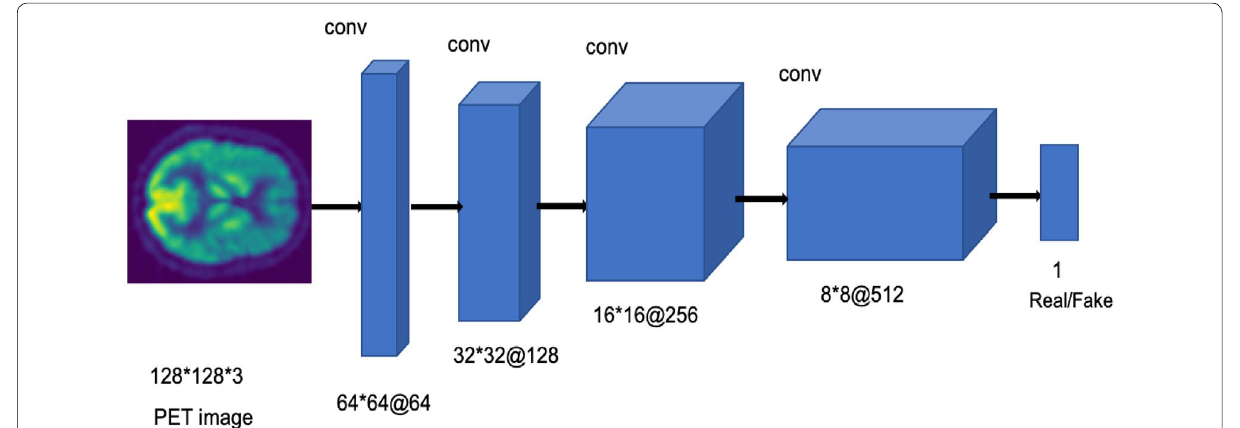
Fig. 5 Discriminator architecture of the proposed